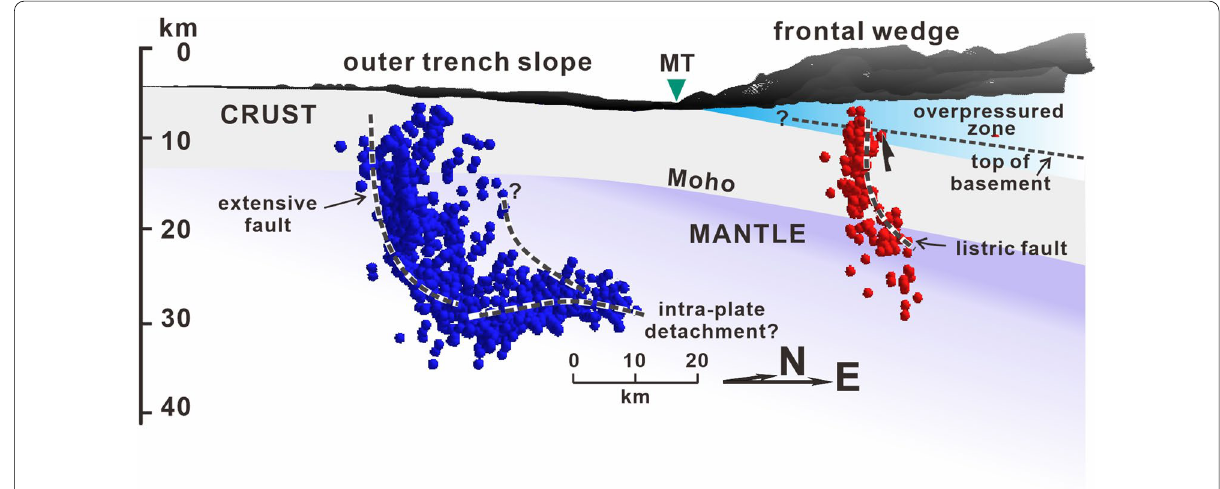
Fig. 8 Schematic of a cross-section through the subducting SCS plate. The red and blue dots are the C2005 and C2006 earthquakes, respectively. MT Manila